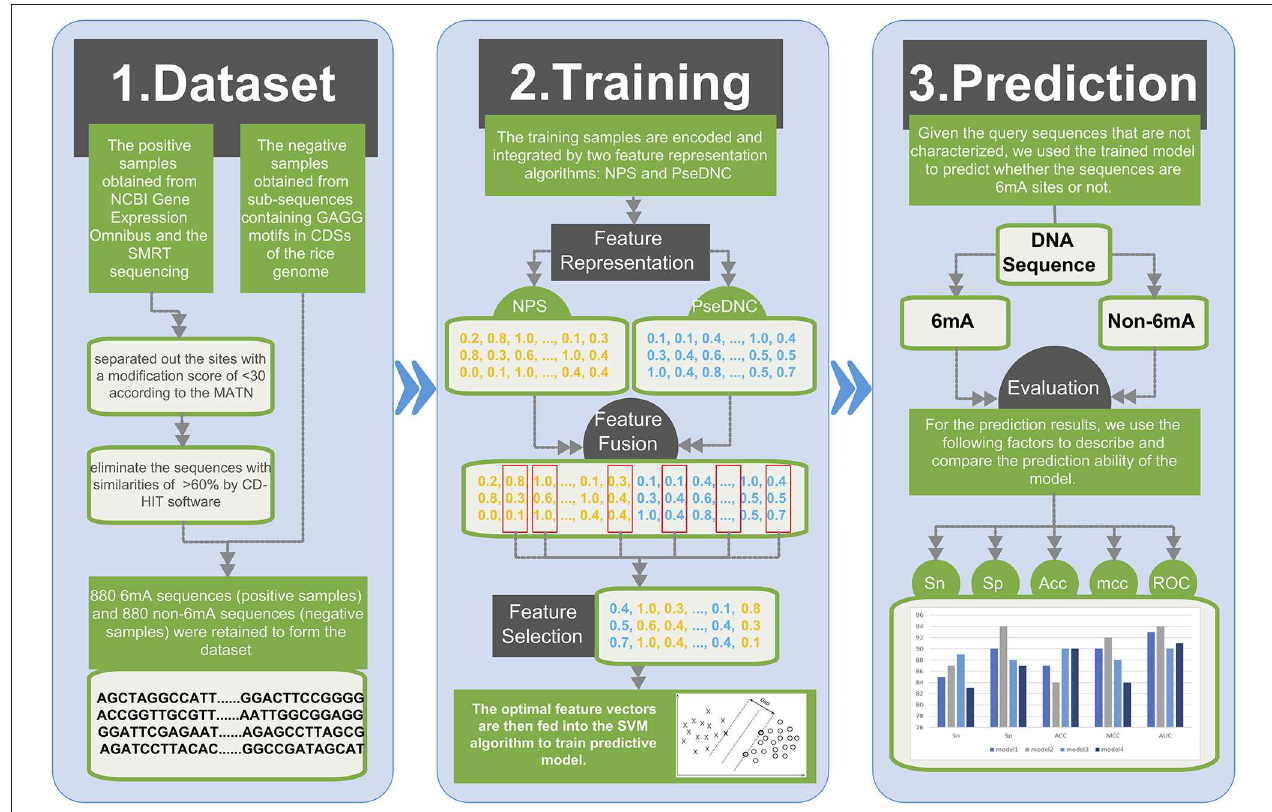
FIGURE 1 | Framework of the proposed 6mAPred-FO. The overall framework is divided into two phases: (1) model training phase and (2) prediction phase. In the model training phase, each DNA sequence is fed to two feature representation algorithms NPS and PseDNC to generate the corresponding features. Afterwards, through the feature fusion and optimization protocol, we yielded the optimal features for each sequence sample. To this end, we train an SVM model with the resulting feature set. In the prediction phase, the model predicts whether the sequence in the test dataset contains 6mA site. And then, compare our model with previous models in terms of ACC, etc. Finally, build a user-friendly web server to provide convenient 6mA site identification and